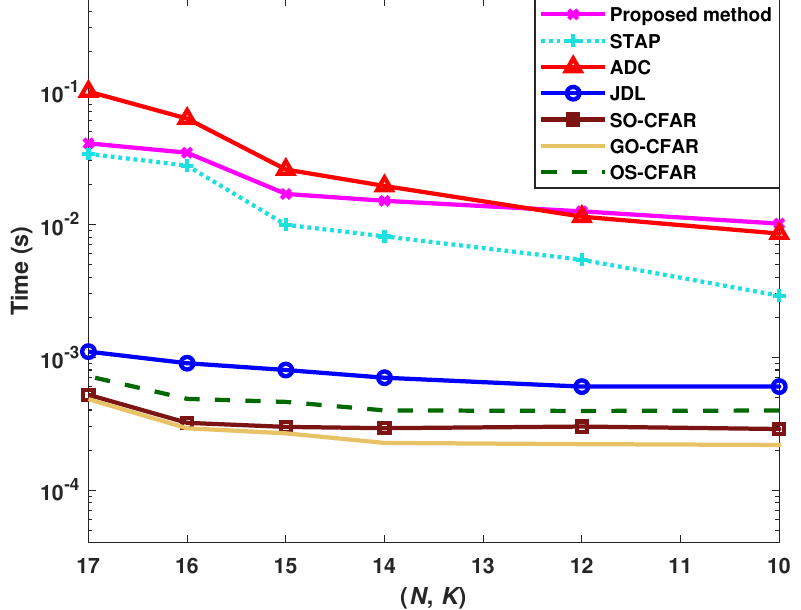
Figure 12. Computation time versus numbers of array elements and pules ( N and K